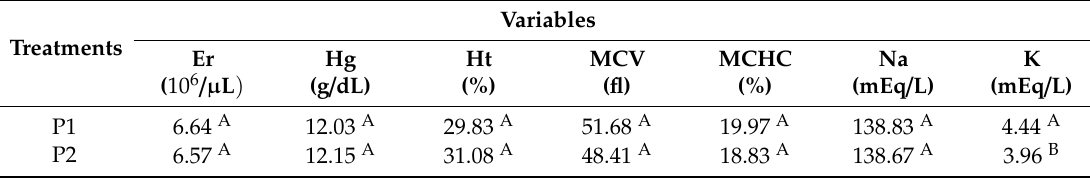
Table 2. Means of hematological and electrolytic variables in P1 and